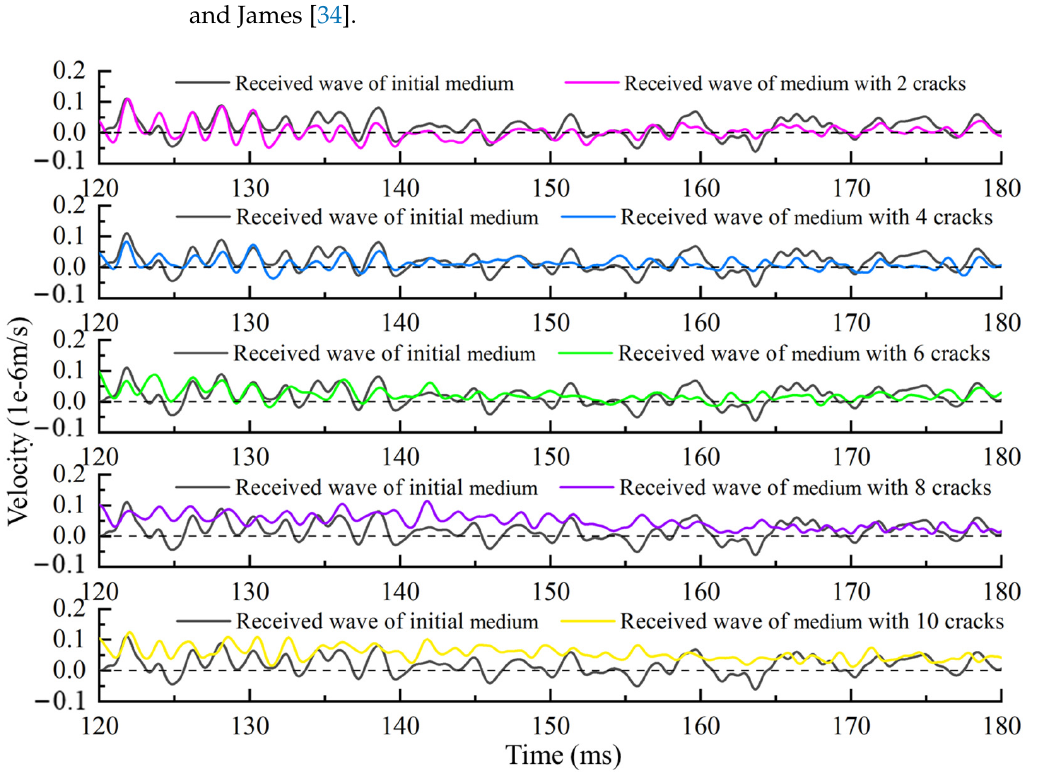
Figure 13. The coda wave before and after the medium change in the simulation.